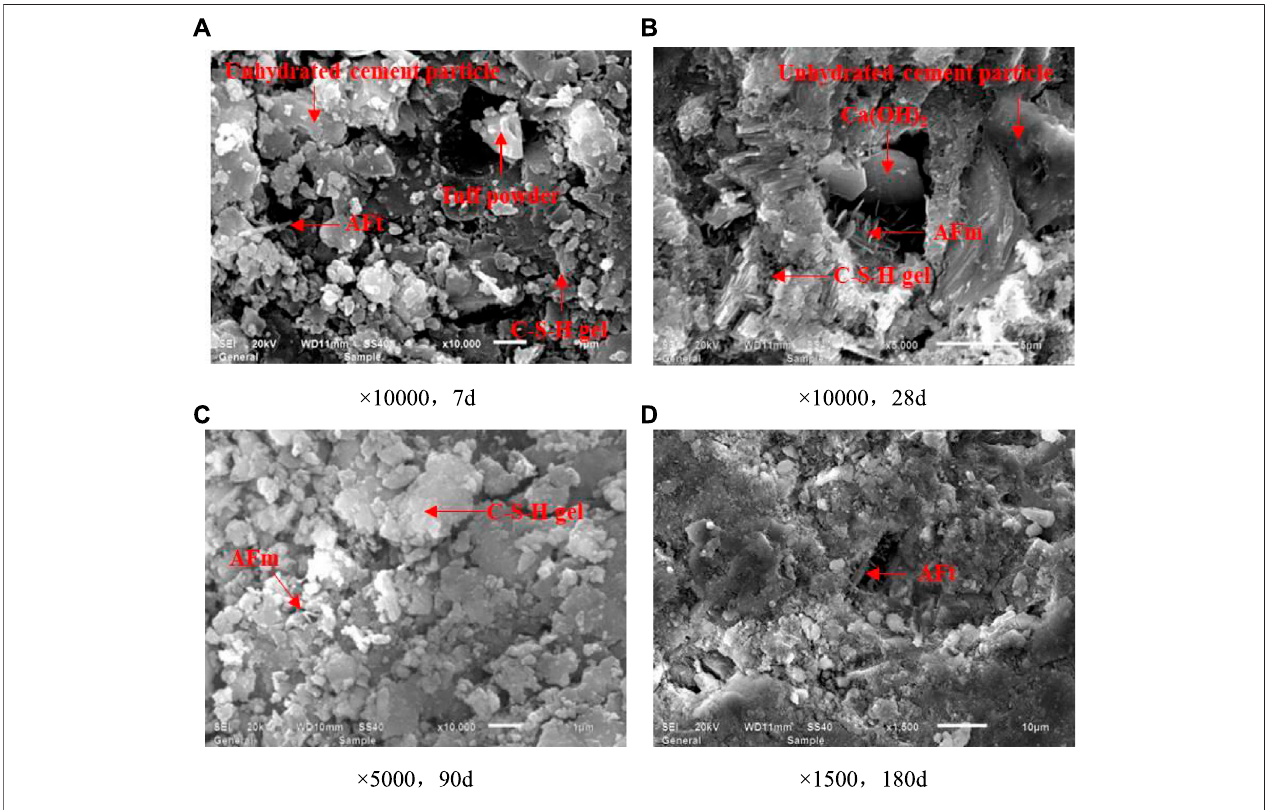
FIGURE 10 | SEM images of hardened paste of NH2 (20% Tuff